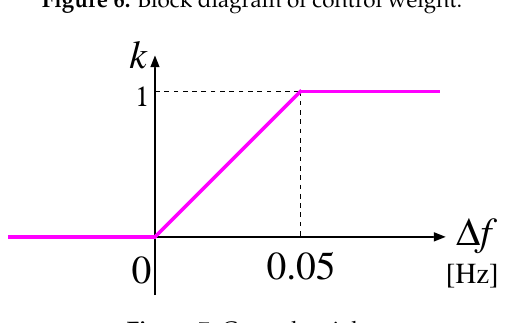
Figure 7. Control